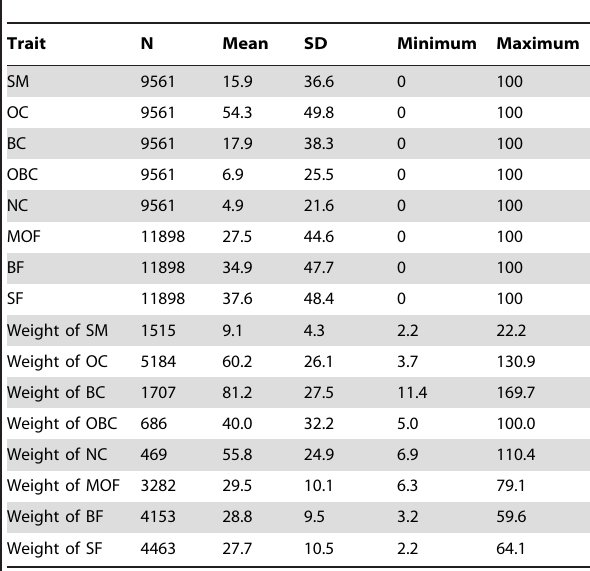
SM = Small male, OC = Orange claw male, BC = Blue claw male, OBC = Old blue claw male and NC = No claw; MOF = Mature ovary female, BF = Berried female and SF = Spawned female.